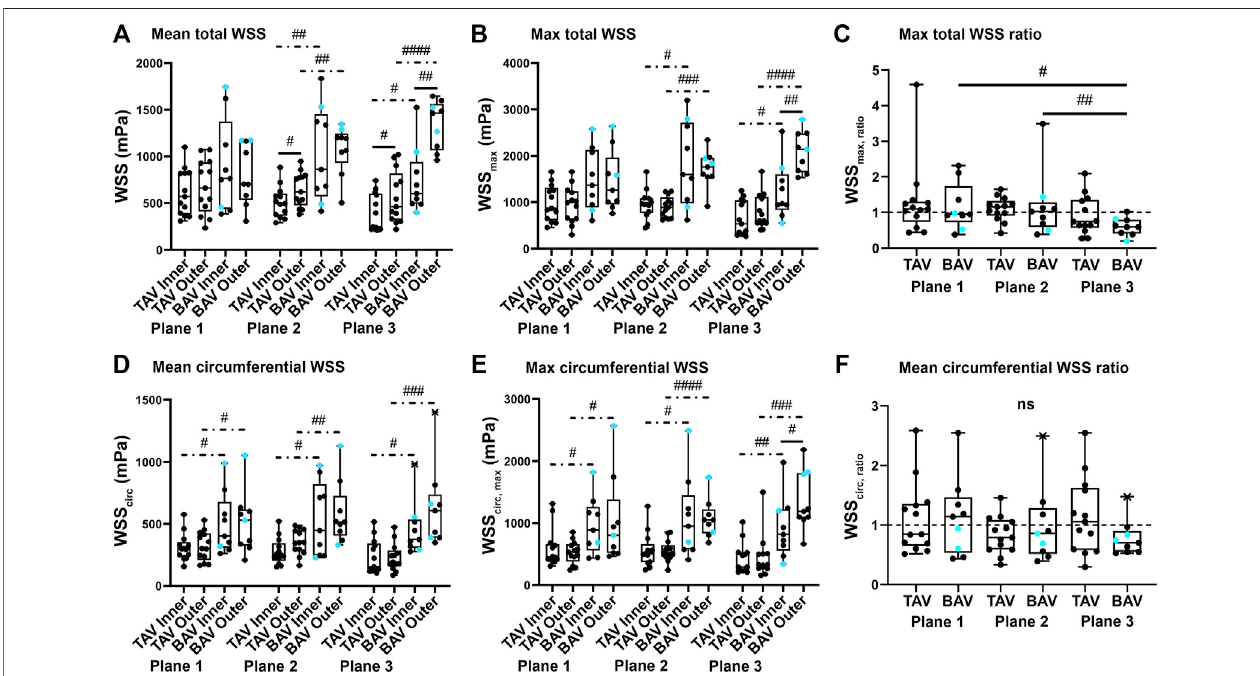
FIGURE 2 | Total and circumferential (circ) wall shear stress (WSS, calculated with patient-speci fi c viscosity) were evaluated on the three planes (with plane one closest to the aortic valve) separately for TAV and BAV patients. Boxplots of mean, maximum, and maximum ratio for total WSS [ (A – C), upper panels ] and similarly mean, maximum, and ratio for circumferential [ (D – F), lower panels ] WSSs were calculated and presented as median and outliers (a cross mark). BAV patients with aortic stenosis are presented with a turquoise circle. p -values < # 0.05, < ## 0.01, < ### 0.001, < #### 0.0001. Hash sign: non-parametric test, solid line: paired experiment, dot-dash line: unpaired